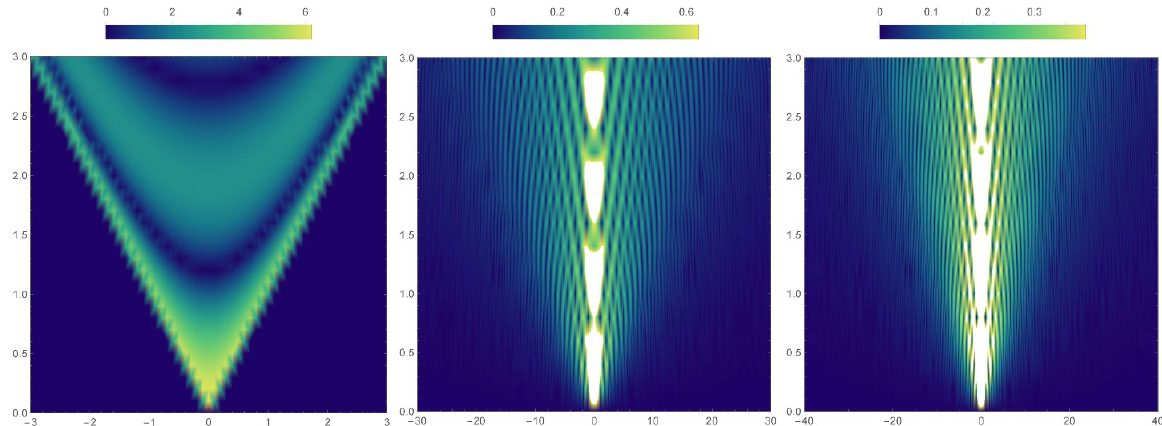
Figure 10 . Density plot for the vacuum expectation value of [ (cid:30) (0 ; 0) ; (cid:30) ( x; t )] in 2 d continuous theory. The plots refer to z = 1 ; 2 ; 3, from left to right respectively. The horizontal axes is x and the vertical axes is t . In all plots we have set m = 2 and the UV cut-o(cid:11) to be (cid:3) = 10 3